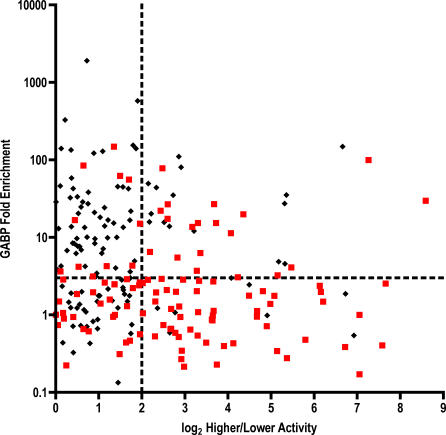
Scatter Plots Depicting the Relationship between GABP ChIP-qPCR Enrichment and Luciferase Activity in HeLa CellsThe majority of divergent promoters (black diamonds) was bound by GABP and exhibited a low log2 activity ratio. General promoters (red squares) exhibited a much broader distribution of log2 H/L expression ratios and lower overall GABP enrichment values. A significant anticorrelation exists between GABP enrichment and log2 H/L activity ratios (Spearman's ρ = −0.1773, P = 0.0067), indicating that high GABP enrichment values, corresponding to bound promoters, are associated with low log2 promoter activity ratios, typical of balanced bidirectional transcriptional activity. Dotted lines indicate the borders of GABP binding (enrichment of 3-fold or greater) and balanced bidirectional activity (log2 H/L less than or equal to 2).